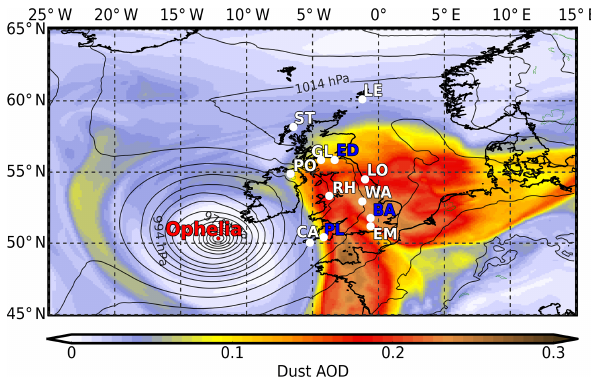
Figure 1. Forecast of dust AOD at 550nm from the Met Office oper- ational global model with sea level pressure. Validity time is 09:00 on 16 October 2017, + 81h from a model run initialised at 00:00 on 13 October 2017. Met Office VA lidar and sun-photometer lo- cations are labelled in white. LE is Lerwick, ST is Stornoway, GL is Glasgow, PO is Portglenone, LO is Loftus, RH is Rhyl, WA is Watnall, EM is East Malling, and CA is Camborne. Other UK sun- photometer sites referred to in the text are labelled in blue; ED is Edinburgh, BA is Bayfordbury, and PL is Plymouth. Lidar sites shown in Fig. 11 are at Camborne, Rhyl, Watnall (mobile system also located at this site), and